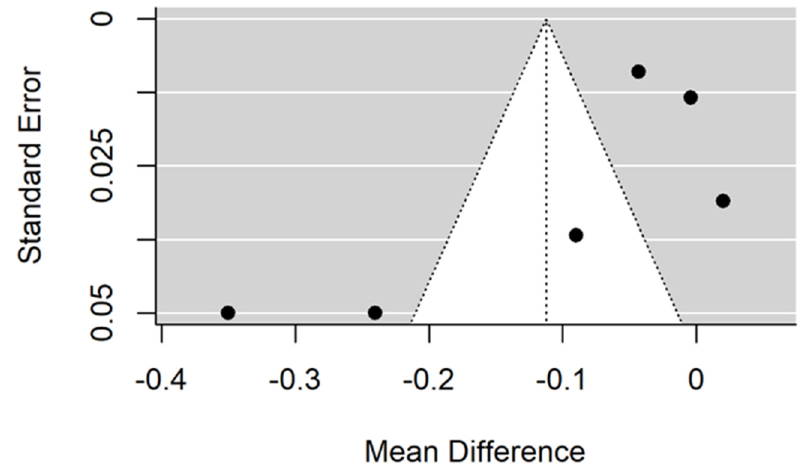
Figure 3. Funnel plot for evalutaion of thread pitch dimension infulence on pull-out strentght in artifical bone model studies.